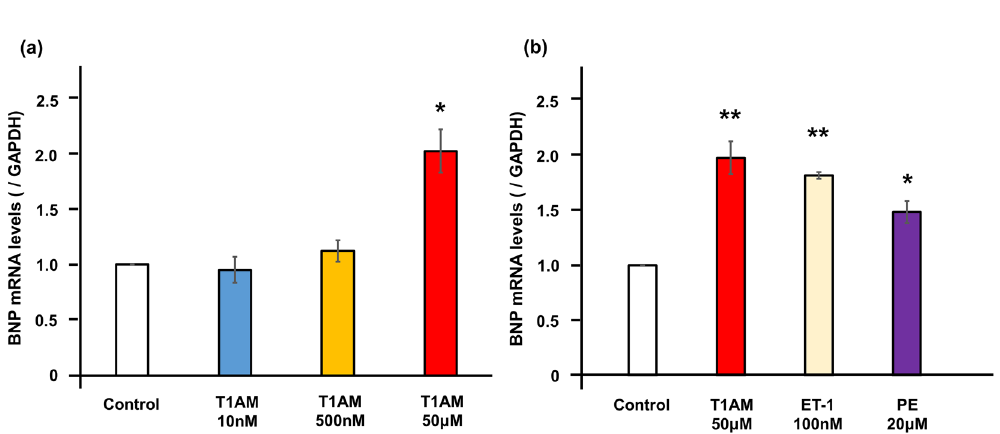
Figure 3. Effects of T1AM on BNP expressions in NRCM. ( a ) The quantification of the BNP gene expression levels in NRCM after 6 h of incubation with or without T1AM were shown (n = 5 each). ( b ) The quantification of the BNP gene expression levels in NRCM after six hours of incubation with T1AM (50 μM), endothelin-1 (100 nM), phenylephrine (20 μM), or vehicle were shown (n = 3 each). The qPCR data were normalized to GAPDH. The data are shown as the fold change normalized to the levels found in vehicle-treated cells (control). * P < 0.05 and ** P < 0.01 versus control. ET-1, endothelin-1; PE,